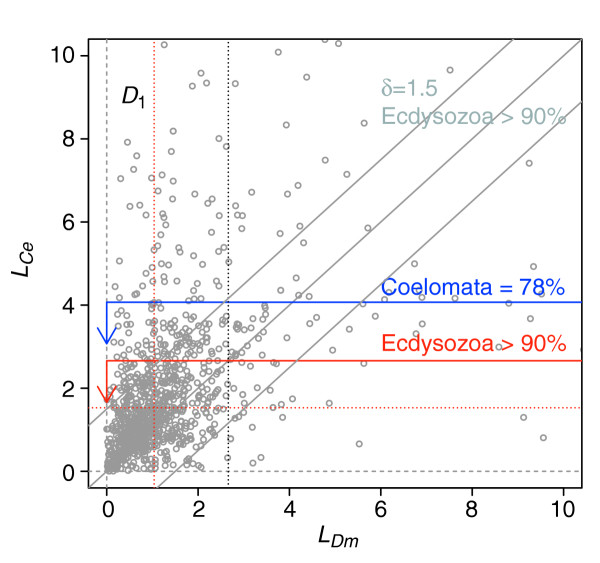
Removing fast-evolving sequences. Exon sequences of C. elegans showing LCe ≥  = 4.06 represent 15% of the total exon. When these faster exons were removed (above blue line), support for the Coelomata topology was reduced from the original 100% to 85%. Furthermore, when 28% of the faster exons were deleted (red line), Ecdysozoa is recovered with 90% statistical support. This suggests that LBAE is the main problem in obtaining the Ecdysozoa tree. Blue line,  = 4.06; red line,  = 2.66.